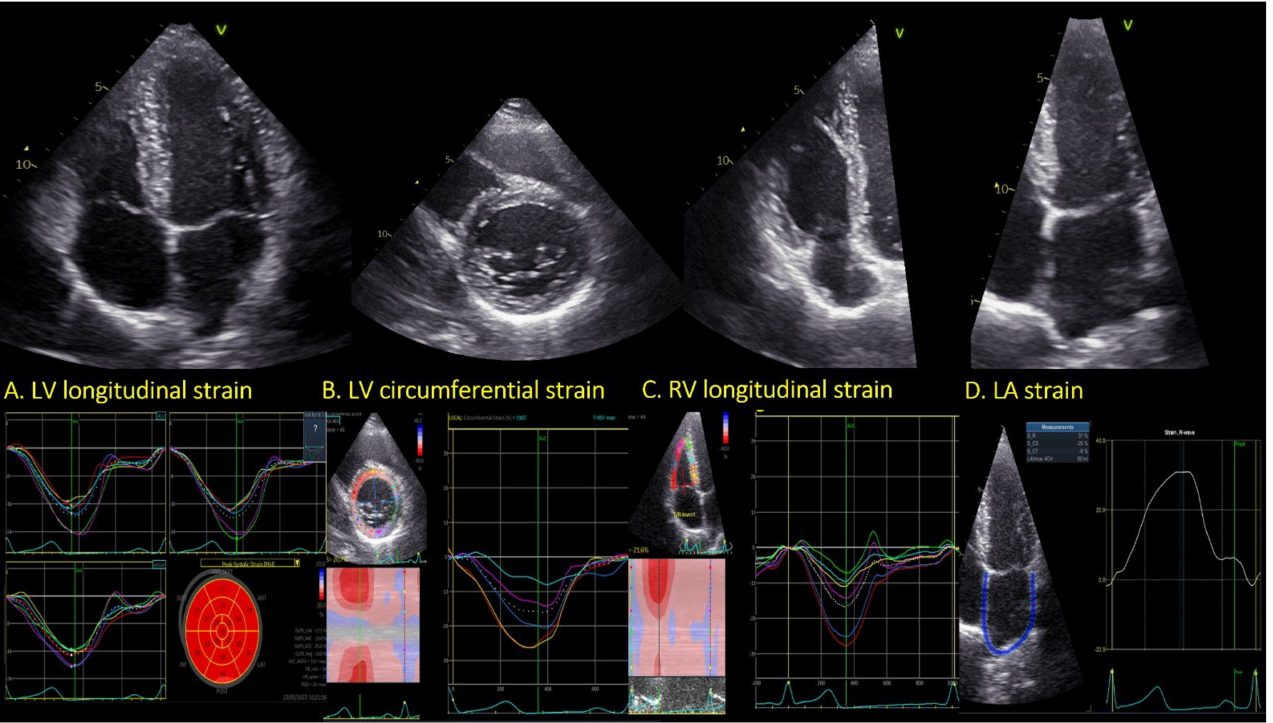
Figure 1. Examples of speckle tracking